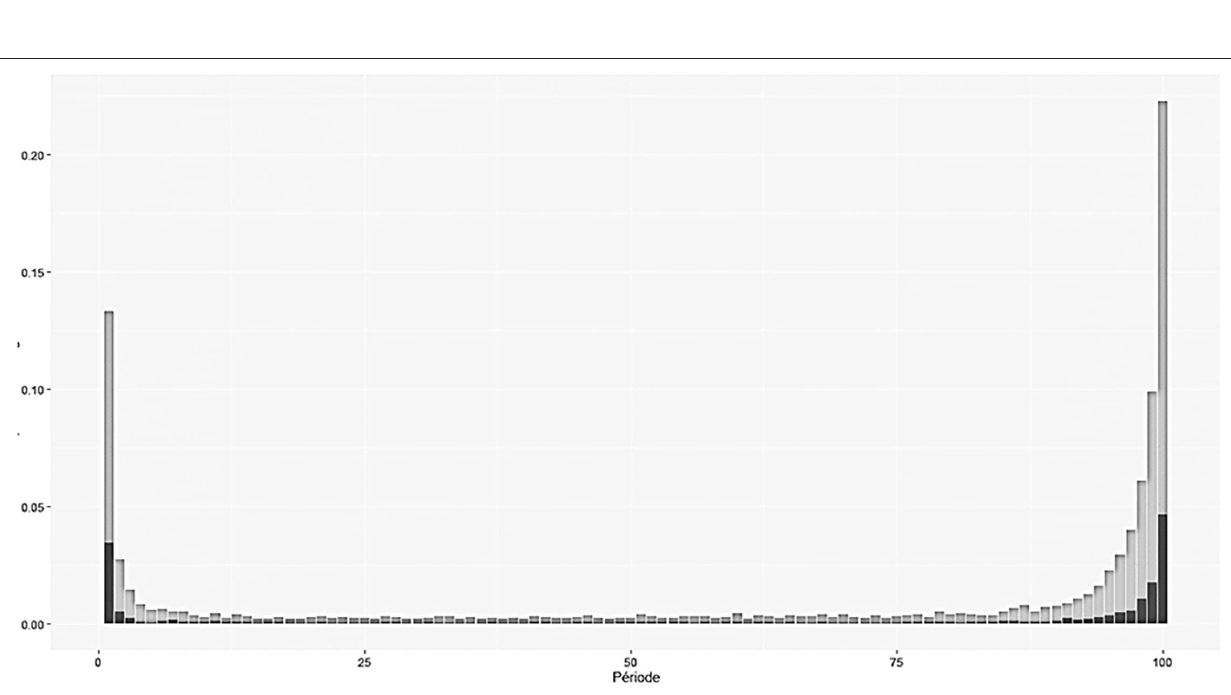
Frontiers in Digital Health | www.frontiersin.org